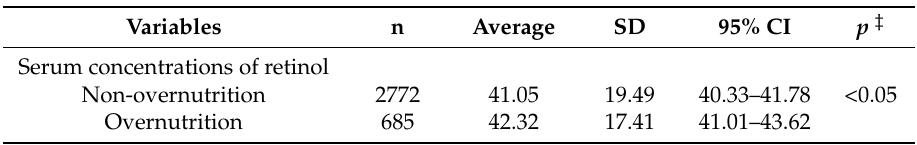
Table 2. Averages, standard deviations, and 95% confidence intervals of serum concentrations of retinol in overnutrition and no-overnutrition children and adolescents.